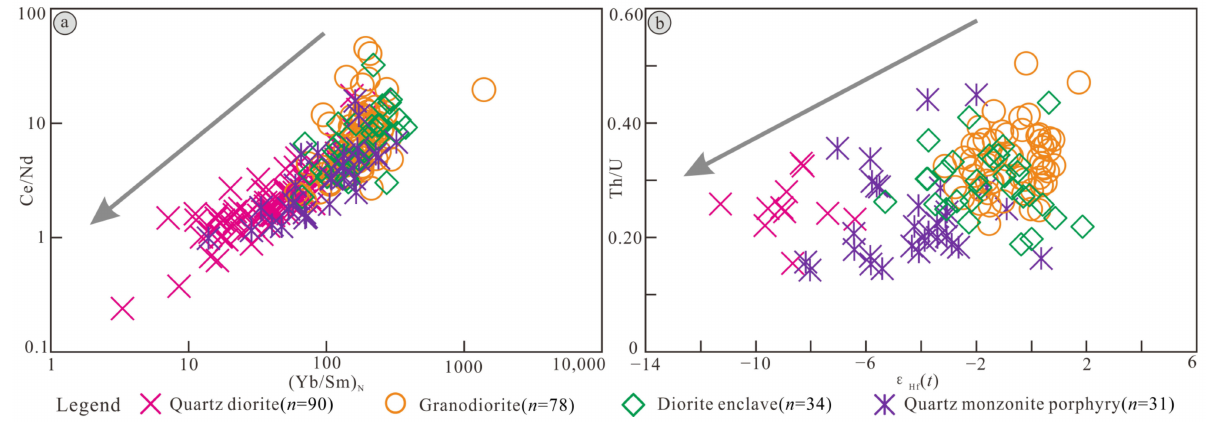
Figure 12. The ( a ) Ce/Nd vs. (Yb/Sm) N ratios and ( b ) Th/U vs. ε Hf ( t ) variation diagrams for studied zircons in the Yangla granitoid intrusions. The data of quartz monzonite porphyry, granodiorite, and dioritic enclaves referred the Meng et al. (2016)